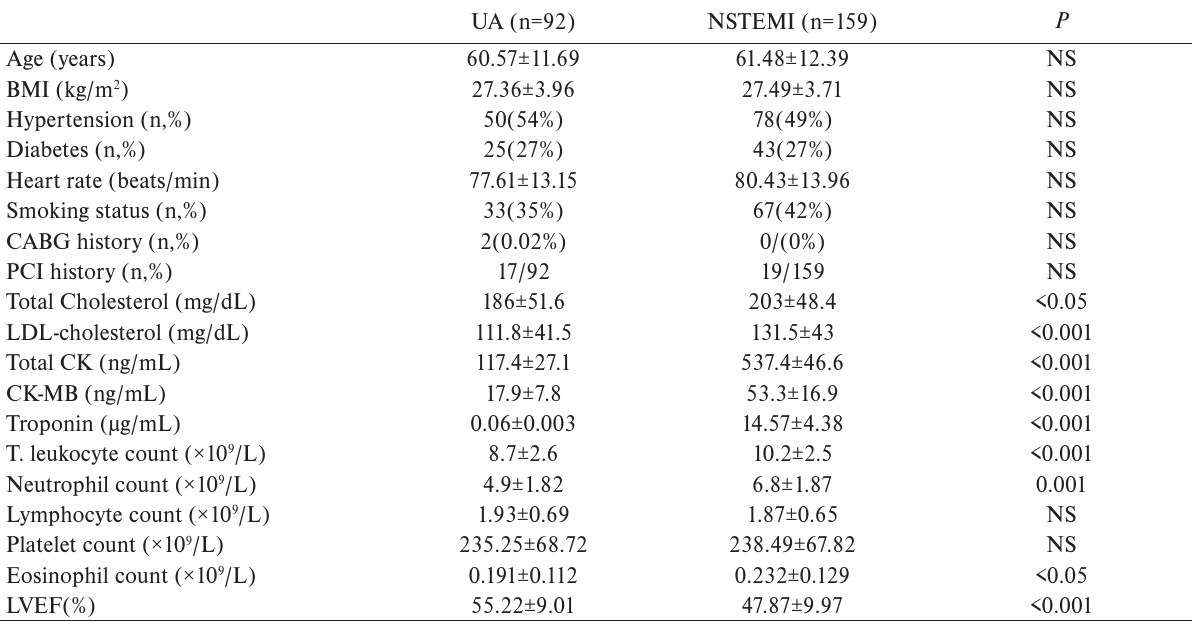
Table 2. Subgroup analyzes of the patients according to the final diagnosis.